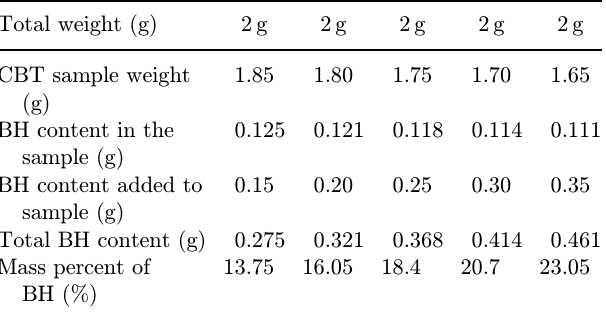
Table 1. A brand of CBT with di®erent mass percentages of BH used in semi-quantitative analysis.